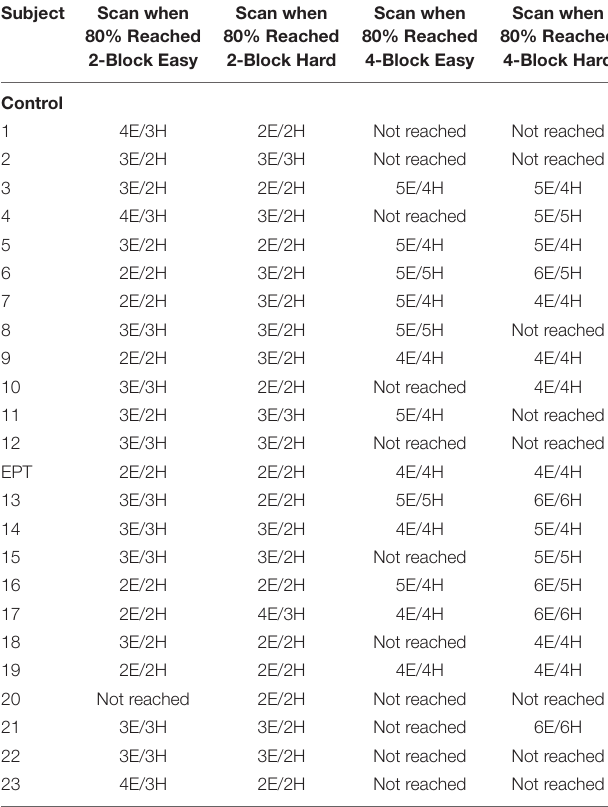
TABLE 2 | Subject early stop durations of the 1-back task using